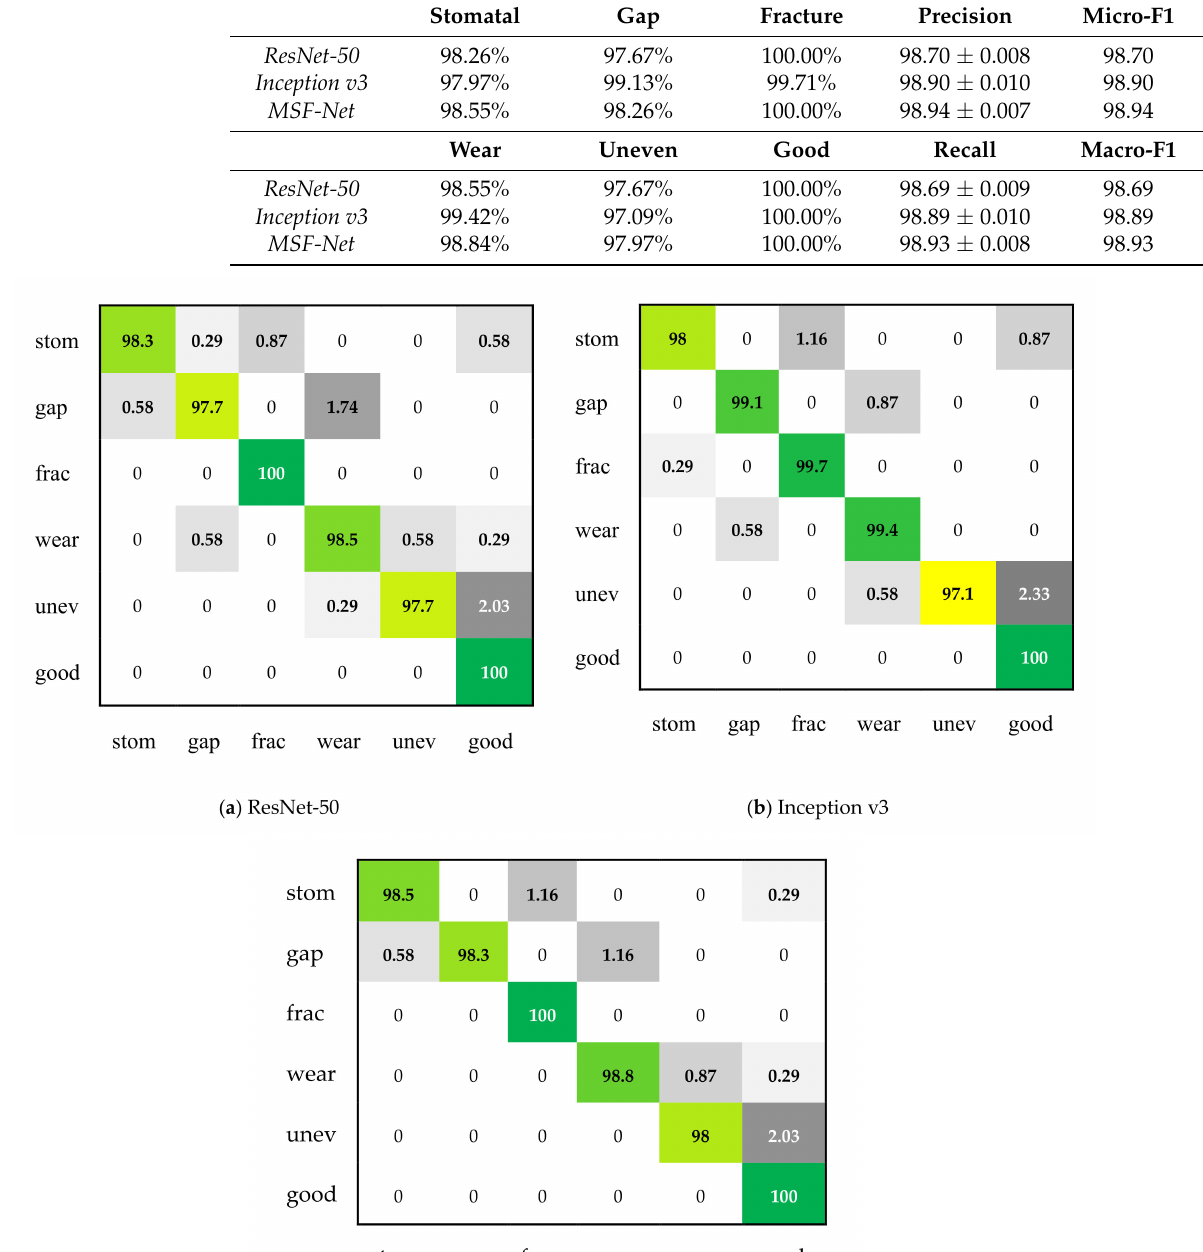
Table 8. Classification performance of three CNNs on the surface defect data set of magnetic tile (%).